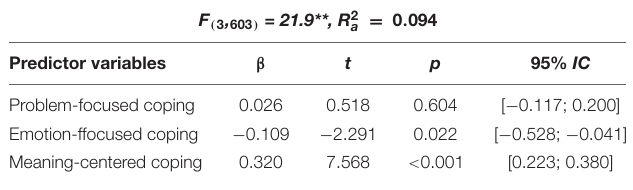
TABLE 4 | Subjective health perception regression model with coping types as predictive variables ( n =